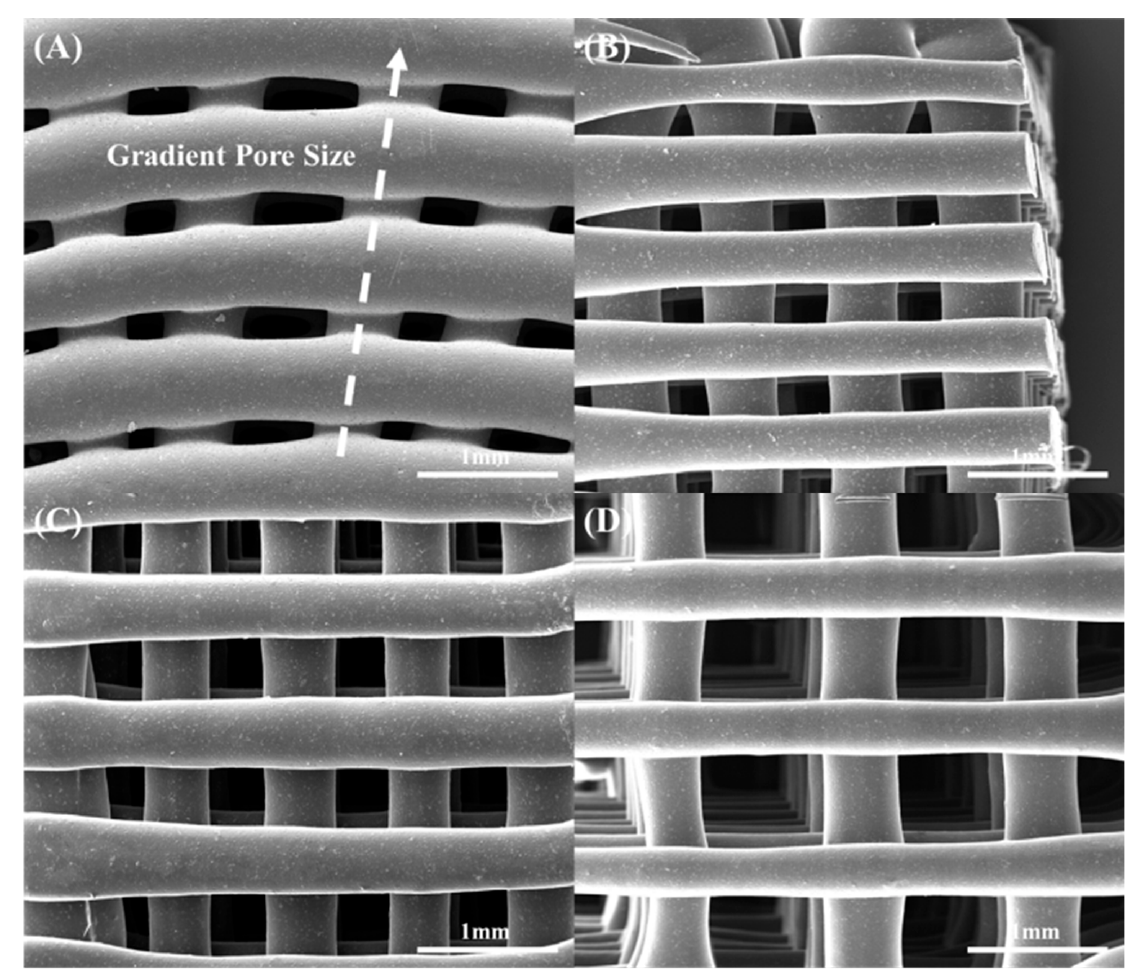
Figure 1. SEM images of ( A ) bone bricks (PCL/bioglass), ( B ) 200 μ m pore size rectangular scaffolds (PCL/bioglass), ( C ) 300 μ m pore size rectangular scaffolds (PCL/bioglass) and ( D ) 500 μ m pore size rectangular scaffolds (PCL/bioglass).